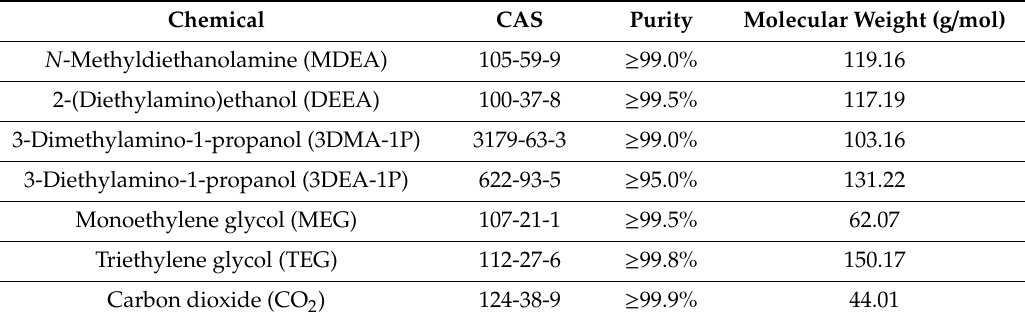
Table 1. Full name, CAS, and purity of all chemicals.